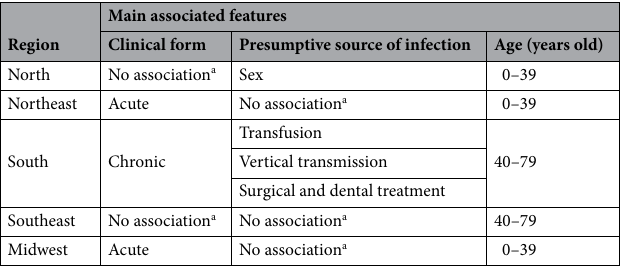
Table 4. Characteristics associated with HBV infection in different regions of Brazil from 2007 to 2018, according to the correspondence analysis. a There was no strong association with at least one source of infection specifically.